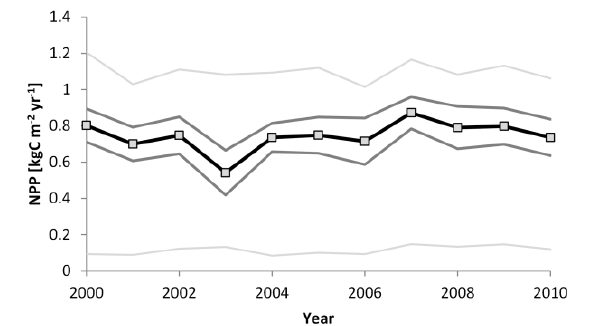
Figure 7. Time series of MODIS-derived NPP of deciduous broadleaf forest in Central Europe. The central line represents mean values, dark grey lines are mean +/– one standard deviation, light grey lines are minimum and maximum.